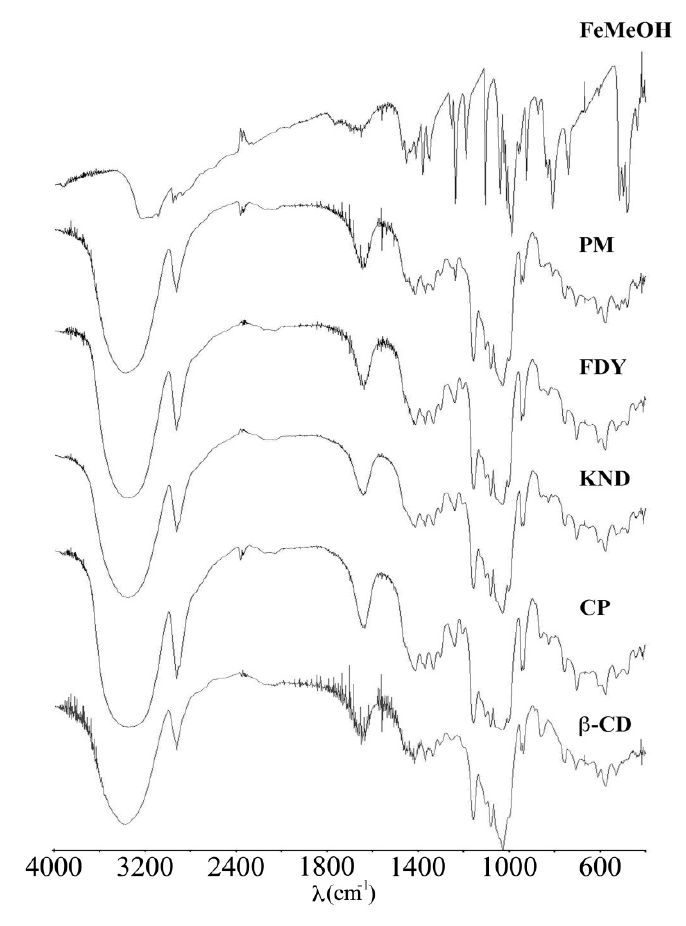
Figure 3. FT-IR spectra of β -CD, CP, KND, FDY, PM and FeMeOH.